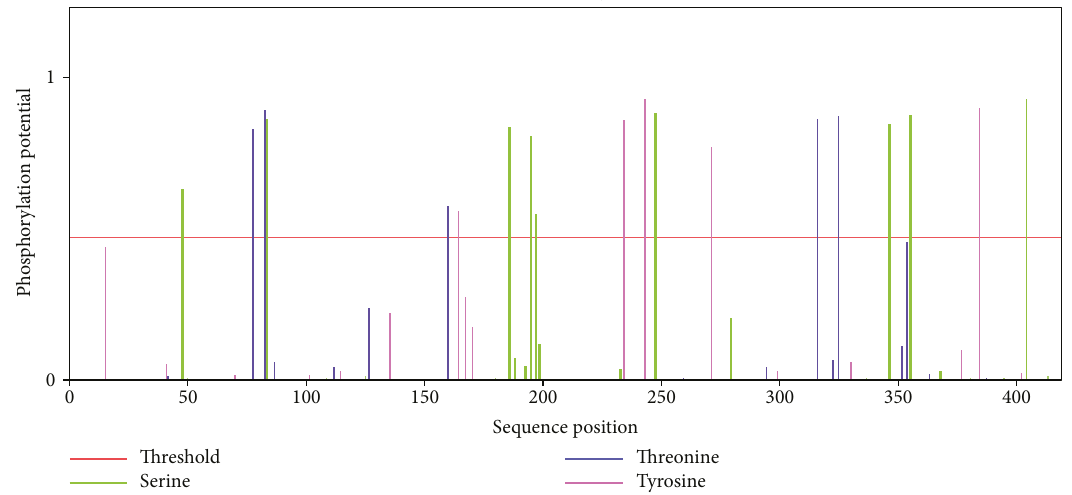
Figure 5: Prediction of phosphorylation sites in GpSS . These include 48S, 84S, 187S, 196S ∗ , 198S, 249S, 349S, 358S, and 407S ∗ ; 78T, 83T, 161T, 318T, and 327T; and 165Y, 236Y, 246Y, 273Y, and